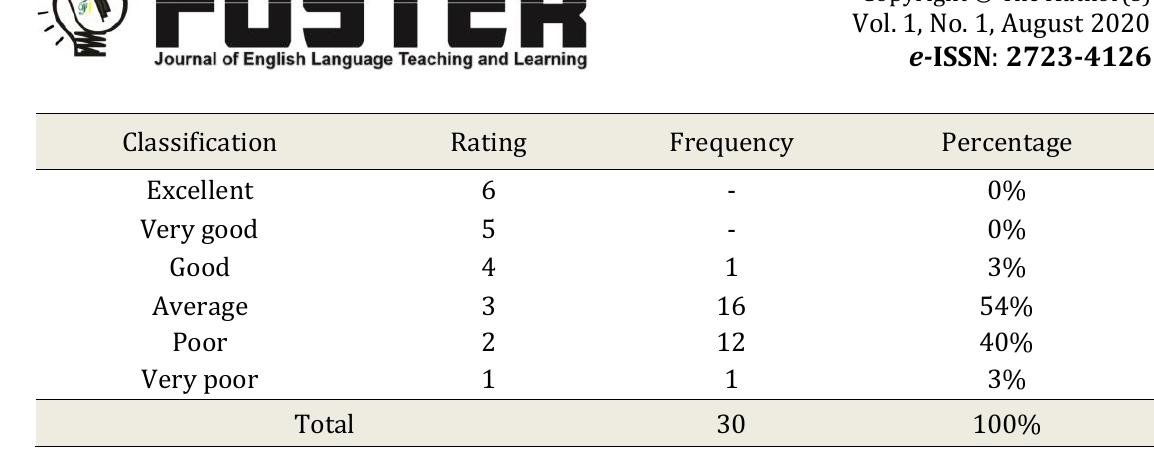
Table 4.7 The Rate Percentage Score of comprehensibility in Pretest Result in Experimental